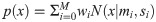
Distribution of the unambiguous Gini indices of countries of the test data set derived from the information provided by the United Nations University World Institute for Development Economics https://www.wider.unu.edu/download/WIID3.3.Left: The density distribution is presented as probability density function, estimated by means of the Pareto Density Estimation (PDE [19]; black line). A Gaussian mixture model (GMM) given as p(x)=Σi=0MwiN(x|mi,si), where mi, si and wi are the parameters mean, standard deviation and relative weight of each of the Gaussians, respectively, was fit (red line) to the data, with a number of mixes of M = 4 (Gaussian, G #1 .. G #4) shown as differently colored lines. The Bayesian boundaries between the Gaussians are shown as perpendicular magenta-colored lines. Empty (white) regions indicate either lack of information or information judged as of poor quality by the publisher. The Fig has been created using the R software package (version 3.4.0 for Linux; http://CRAN.R-project.org/ [18]); specifically, the GMM was drawn using our R package “AdaptGauss” (https://cran.r-project.org/package=AdaptGauss [25]). Right: A quantile-quantile plot comparing the observed distribution of standardized Gini indices with the distribution expected from the GMM (abscissa).